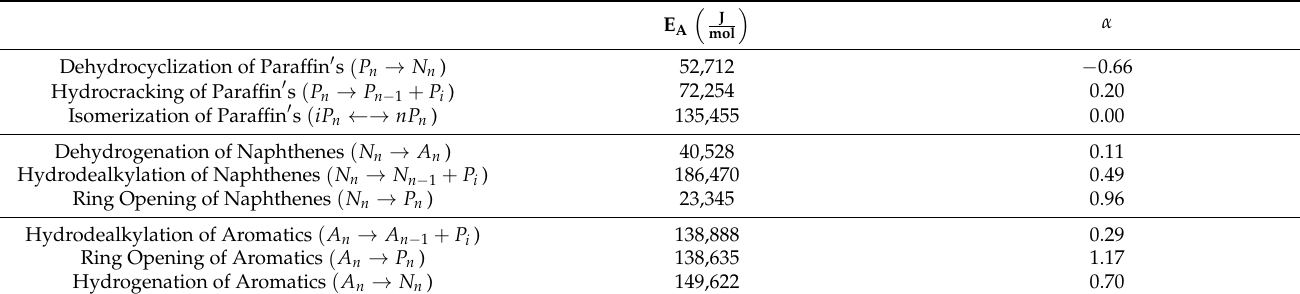
Table 3. Activation energies of predicted kinetic